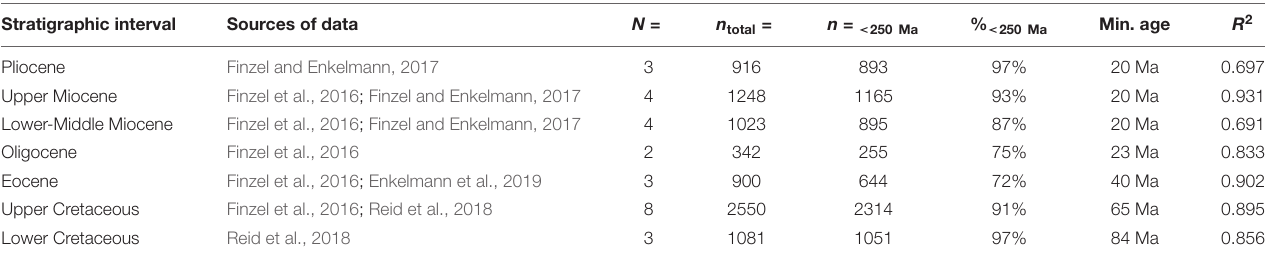
TABLE 2 | Data and model information for each stratigraphic